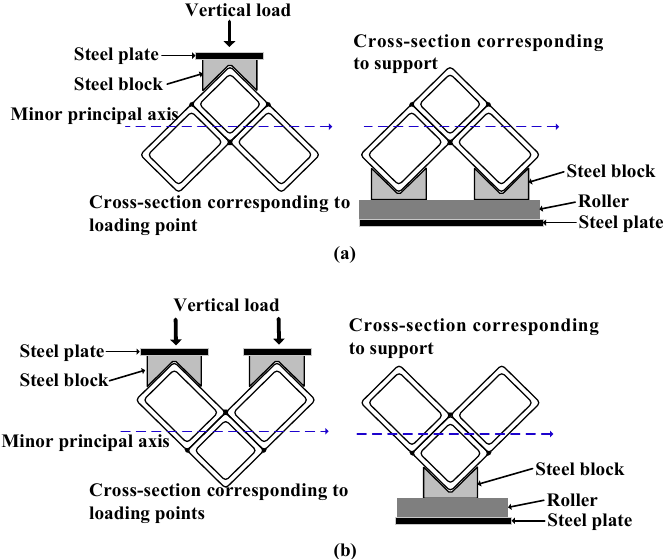
Figure 10. Cross-section corresponding to loading points and supports: ( a ) Load at the heel; ( b ) Load at the toes. An overall view of the four-point bending test is shown in Figure 11. Two linear var- iable displacement transducers (LVDTs) were installed to measure the vertical displace- ments at the two loading points, while one LVDT was placed to record the vertical dis- placements at the mid-span of the specimen. Another two LVDTs, located at both ends of the specimen, were used to measure the rotations during the loading process.